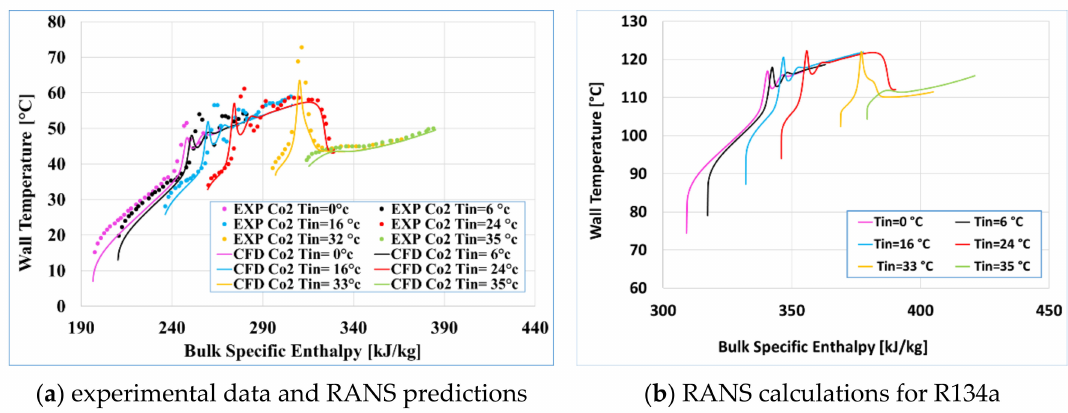
Figure 19. Trends of the wall temperature along the channel for the reference cases by Kline at q (cid:48)(cid:48) = 20 kW/m compared with the trends of the wall temperature along the channel. RANS calculations with R134a at 4.47 MPa for the reference cases by Kline at q (cid:48)(cid:48) = 20